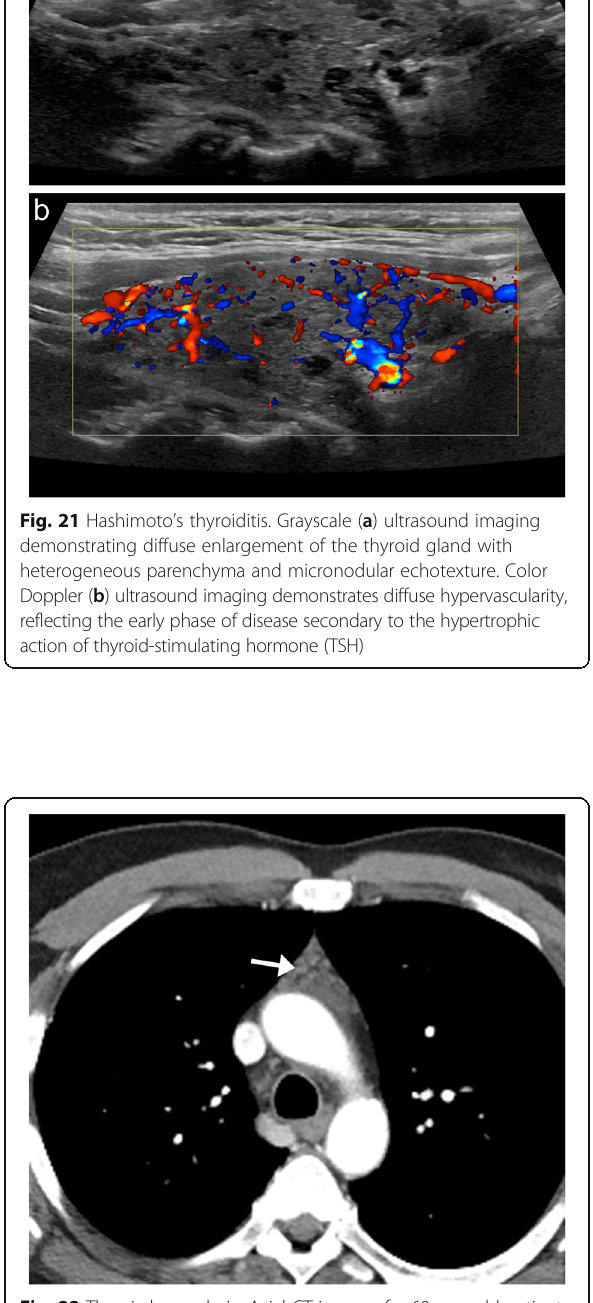
Fig. 22 Thymic hyperplasia. Axial CT image of a 60-year-old patient undergoing chemotherapy demonstrates an anterior mediastinal mass (arrow) with the expected location, configuration, and attenuation of the thymus gland, consistent with rebound thymic hyperplasia secondary to chemotherapy. It is important to distinguish thymic hyperplasia from thymoma, which can present as asymmetry of the lobes, focal contour abnormality, and demonstrate focal increased FDG